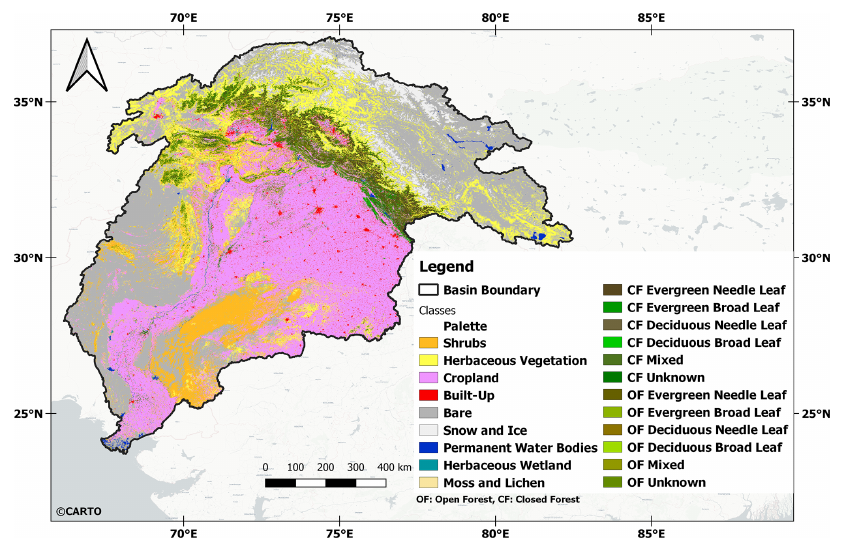
Figure 2. The land use land cover map (100m resolution) of the Indus Basin for 2016, obtained from the Copernicus Global Land Cover Service. Background map